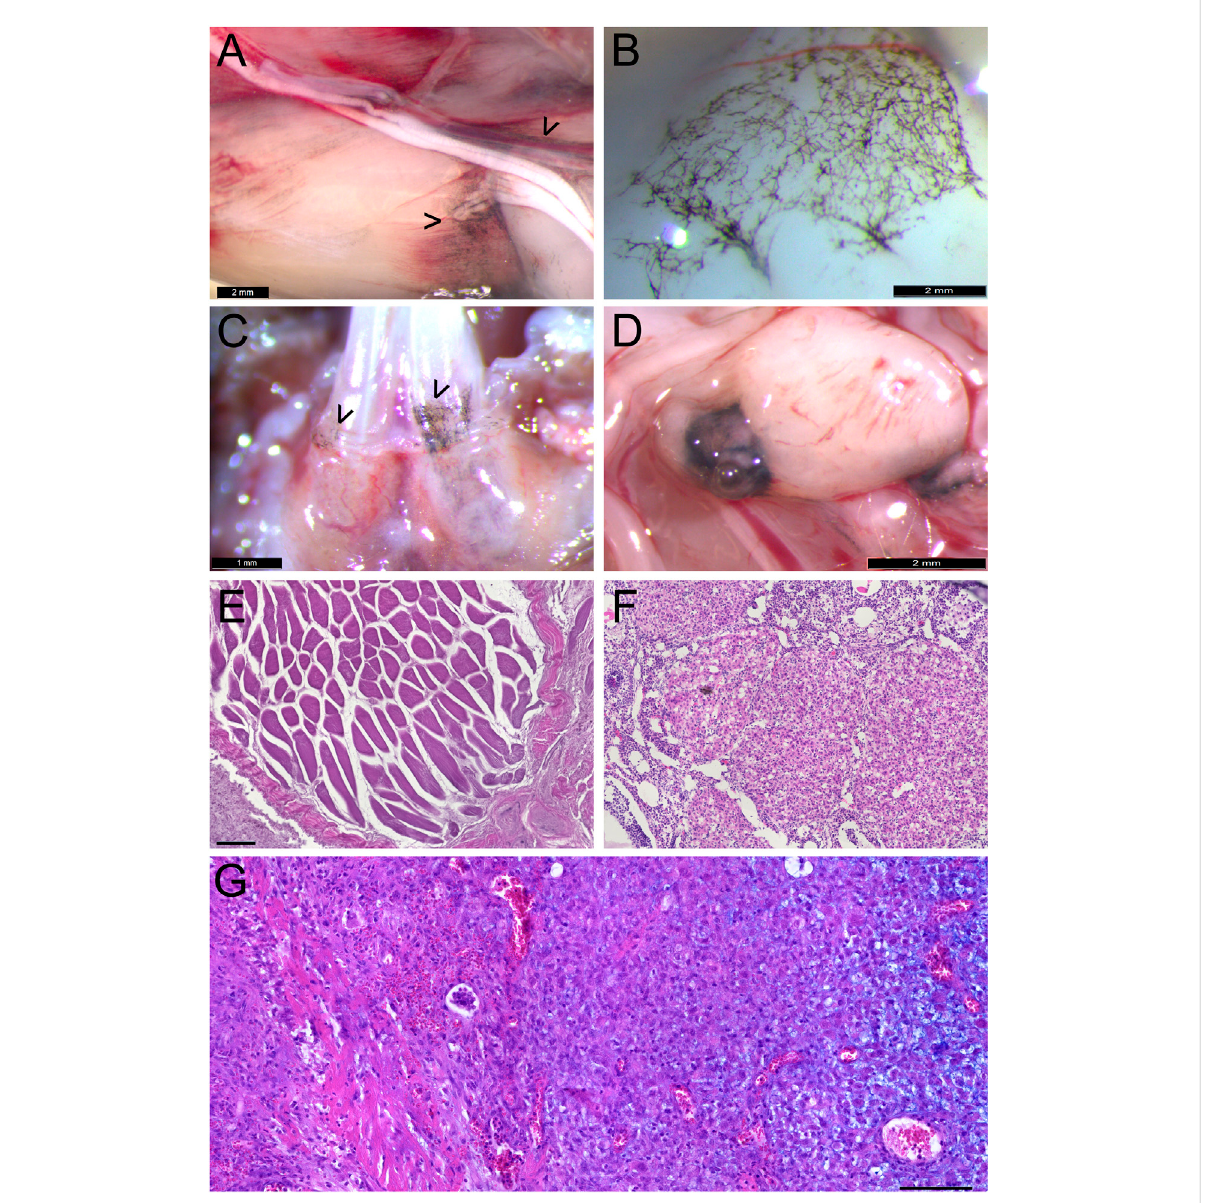
Widespread melanocytic anomalies in conjunction with Krox20-or Sox10-driven expression of constitutively active Pik3ca. (A) Extracutaneous pigmented melanocyte deposits along nerves and muscle fascia in Krox20-Cre +/ ° ; Pik3ca H1047R/+ mice, close to vascular anomalies. Bar = 2 mm. (B) Increased meningeal melanocytosis over ventromedial frontal lobes and olfactory bulbs in Krox20-Cre +/ ° ; Pik3ca H1047R/+ mutants, not seen in 4OH- TAM-treated Sox10-Cre +/ ° ; Pik3ca H1047R/+ mice. Bar = 2 mm. (C) Pigmented, gingival melanocytosis over lower incisors of Krox20-Cre +/ ° ; Pik3ca H1047R/+ mutants, not seen in 4OH-TAM-treated Sox10-Cre +/ ° ; Pik3ca H1047R/+ mice. Bar = 1 mm. (D) Melanoma in Krox20-Cre +/ ° ; Pik3ca H1047R/+ mutant mouse near seminal gland. Bar = 2 mm. (E) Rhabdomyomatous mesenchymal hamartoma in thigh of Krox20-Cre +/ ° ; Pik3ca H1047R/+ mutant mouse. Bar = 100 µm. (F) Ovary of Sox10-CreER T2 ; Pik3ca H1047R/+ mouse induced at 15 weeks by 1 mg 4OH-TAM, after 5 days. (G) Unpigmented, myxoid melanoma in tail of prenatally induced Sox10-CreER T2 ; Pik3ca H1047R/+ mouse, after nearly 1 year. Bar = 100